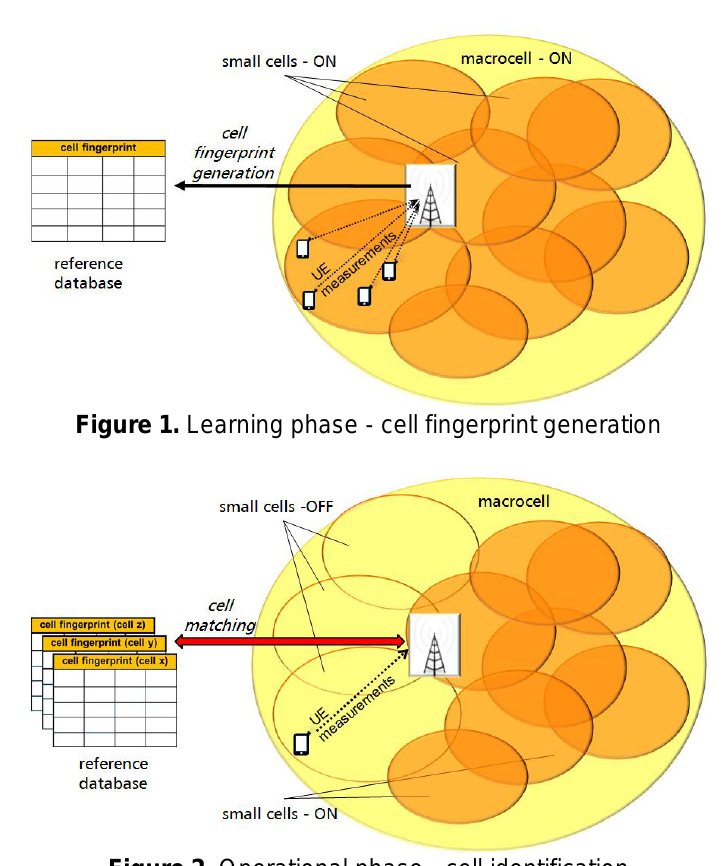
Figure 2. Operational phase - cell